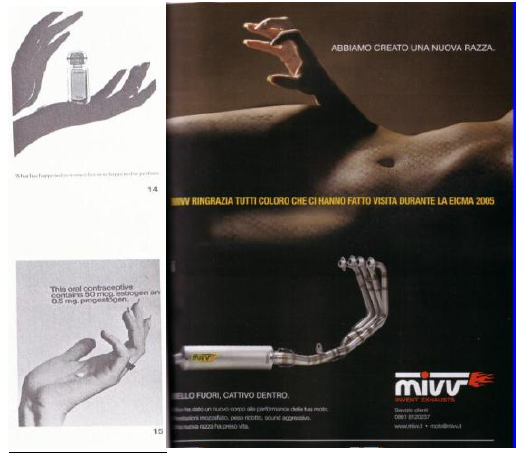
Figure A4. Goffman’s picture and selected picture, body without head.